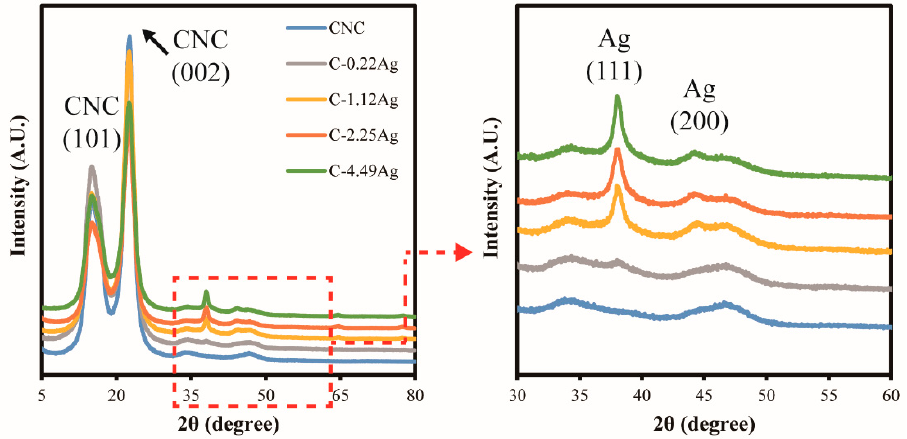
Figure 3. XRD patterns of neat CNC and CNC-AgNP composite films.